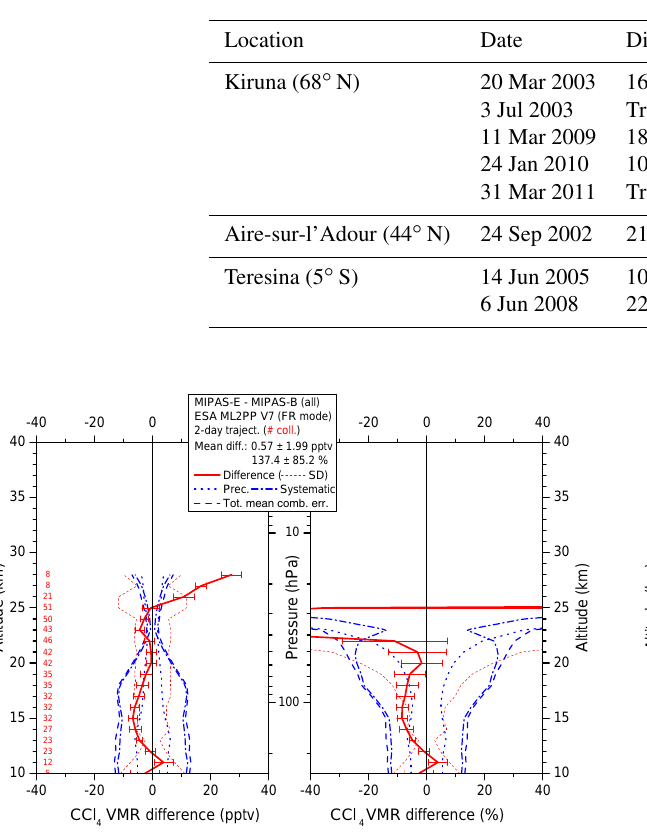
Table 2. Overview of MIPAS balloon flights used for intercomparison with MIPAS/ENVISAT.